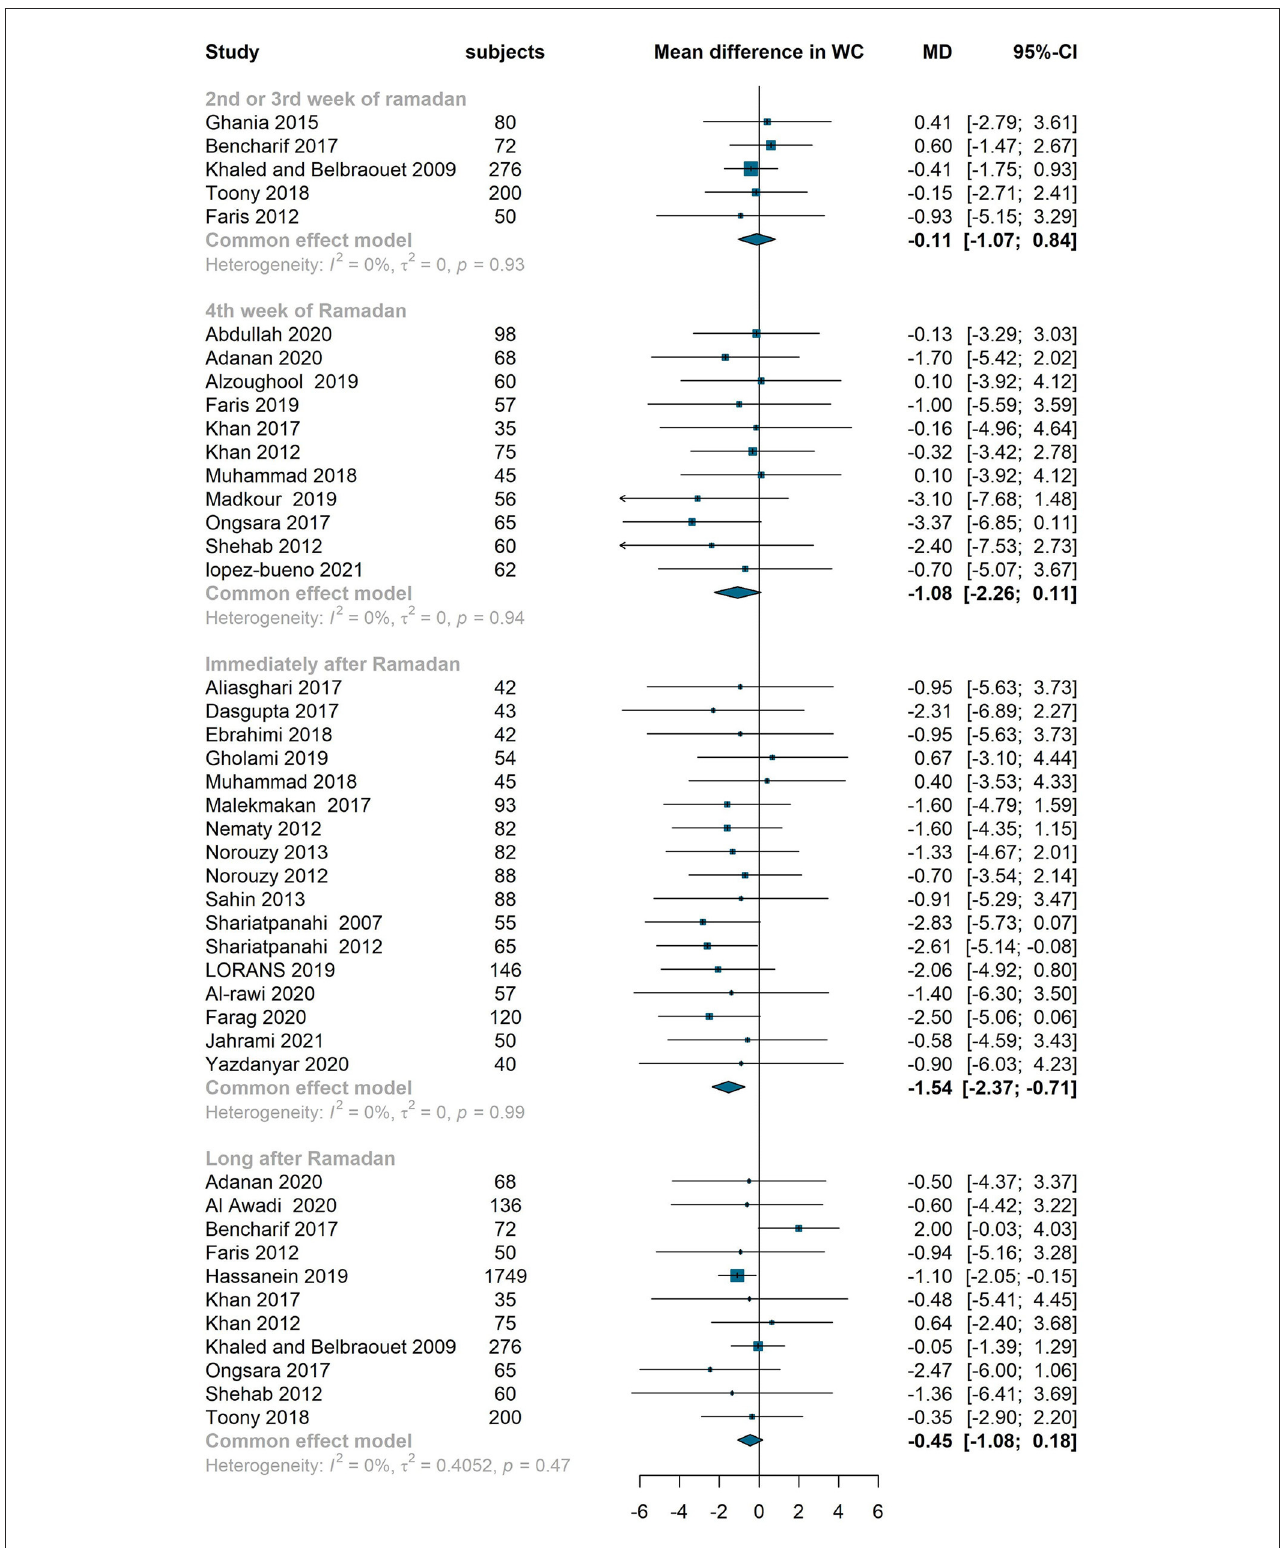
FIGURE5 Fixed effect meta-analysis of RIF effect on